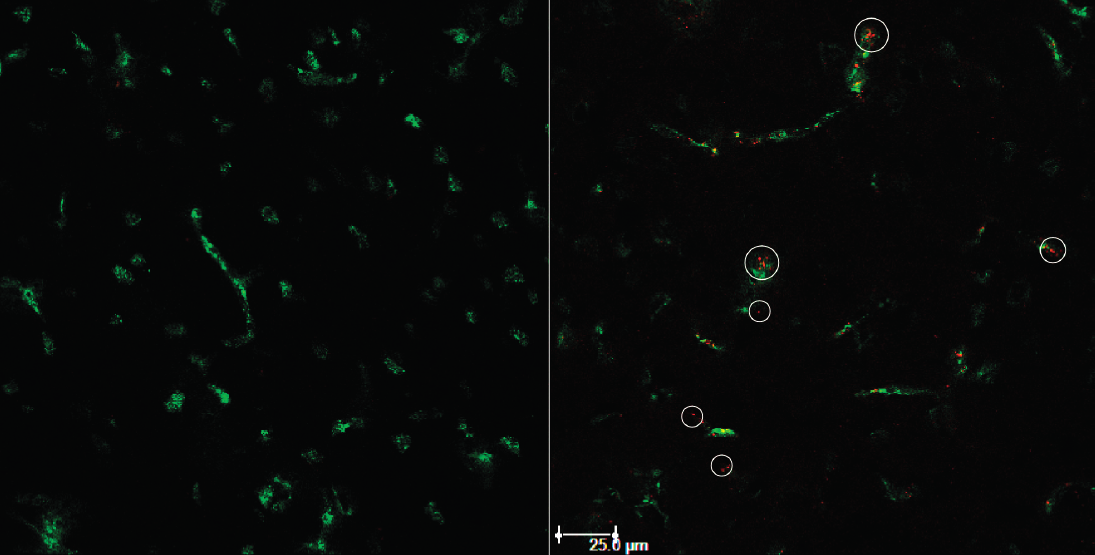
Figure 5. Exemplary image of rat brain cryosection after 1 h of cBSA-liposome incubation ( right ) with control ( left ). Capillaries have been stained with fluorescein labelled cBSA (FITC-BSA) (green). Liposomal rhodamine B (red).